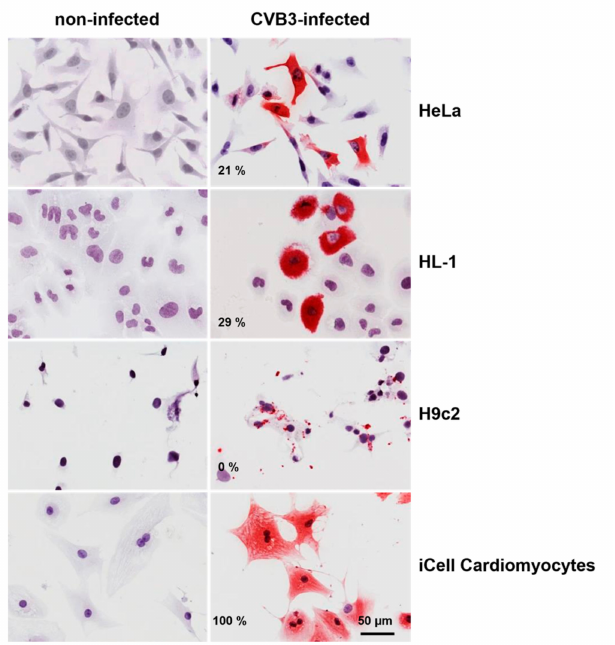
Figure 2. RNA/RNA in situ hybridization for CVB3 RNA localization in different infected cell lines. Cells were infected with a multiplicity of infection (MOI) of 10 and analyzed after eight hours. The percentage of infected cells is indicated in the left lower corner, respectively.